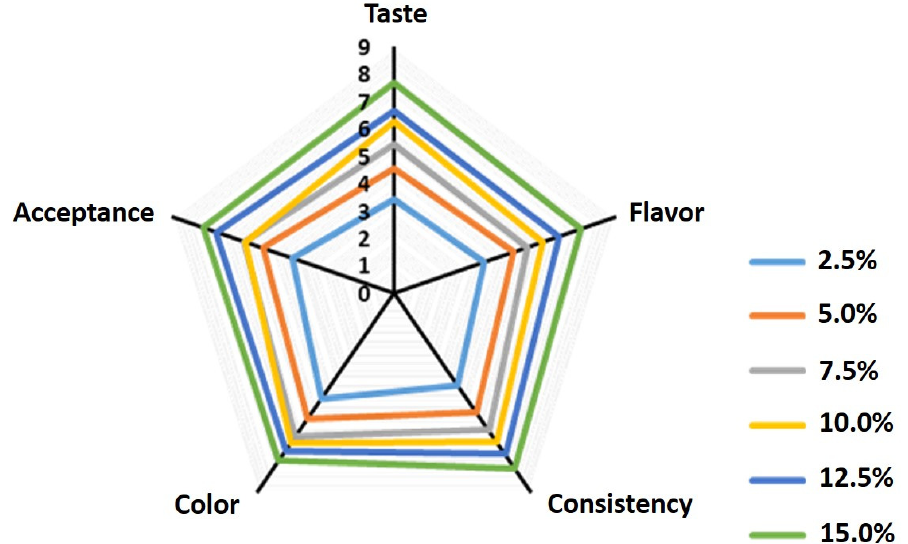
Figure 1. Sensory preference of laban drink fortified with different concentrations (2.5, 5.0, 7.5, 10.0, 12.5, and 15.0%) of date syrup.